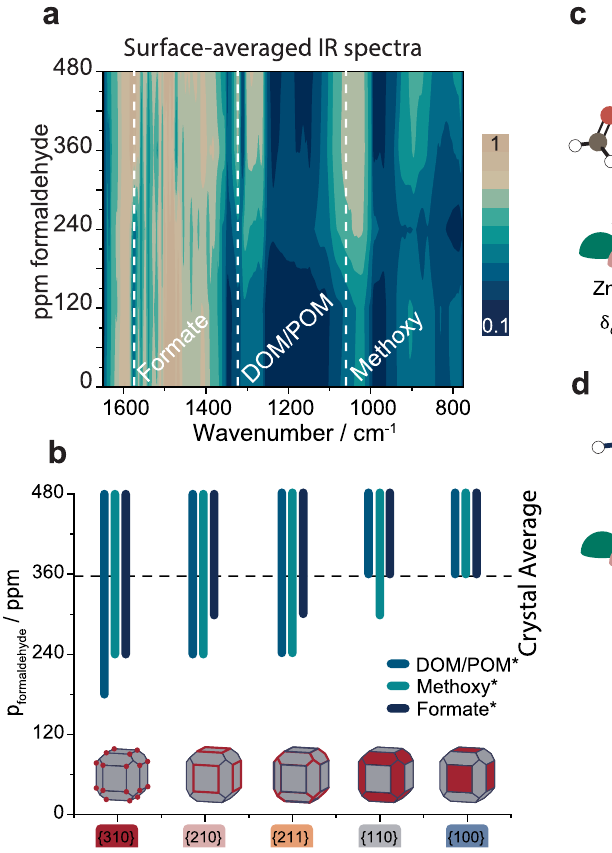
Fig. 5 | Structure-sensitive conversion of formaldehyde (FA) over defect- engineered ZIF-8. a Contour plot of the crystal surface-averaged in situ infrared spectra of a defective ZIF-8 crystal, showing the formation of formate, di-/poly- oxymethylene(DOM/POM),andmethoxysurfacespecies(relevantbandsindicated by dashed lines in the contour plot). b A plot showing plane-dependent response pressures for intermediate surface species, thus showing structure-sensitive FA